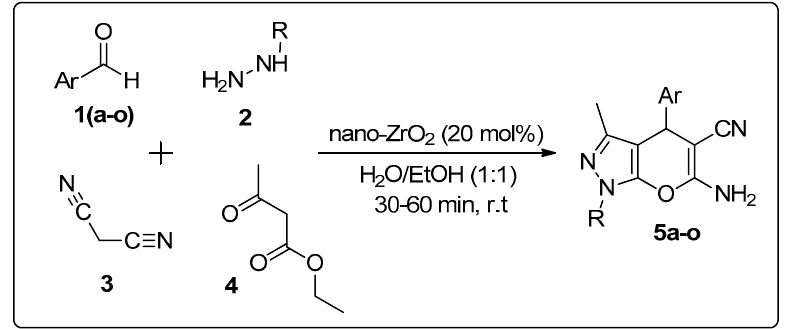
Scheme 2. General schematic representation for the synthesis of pyranopyrazoles.